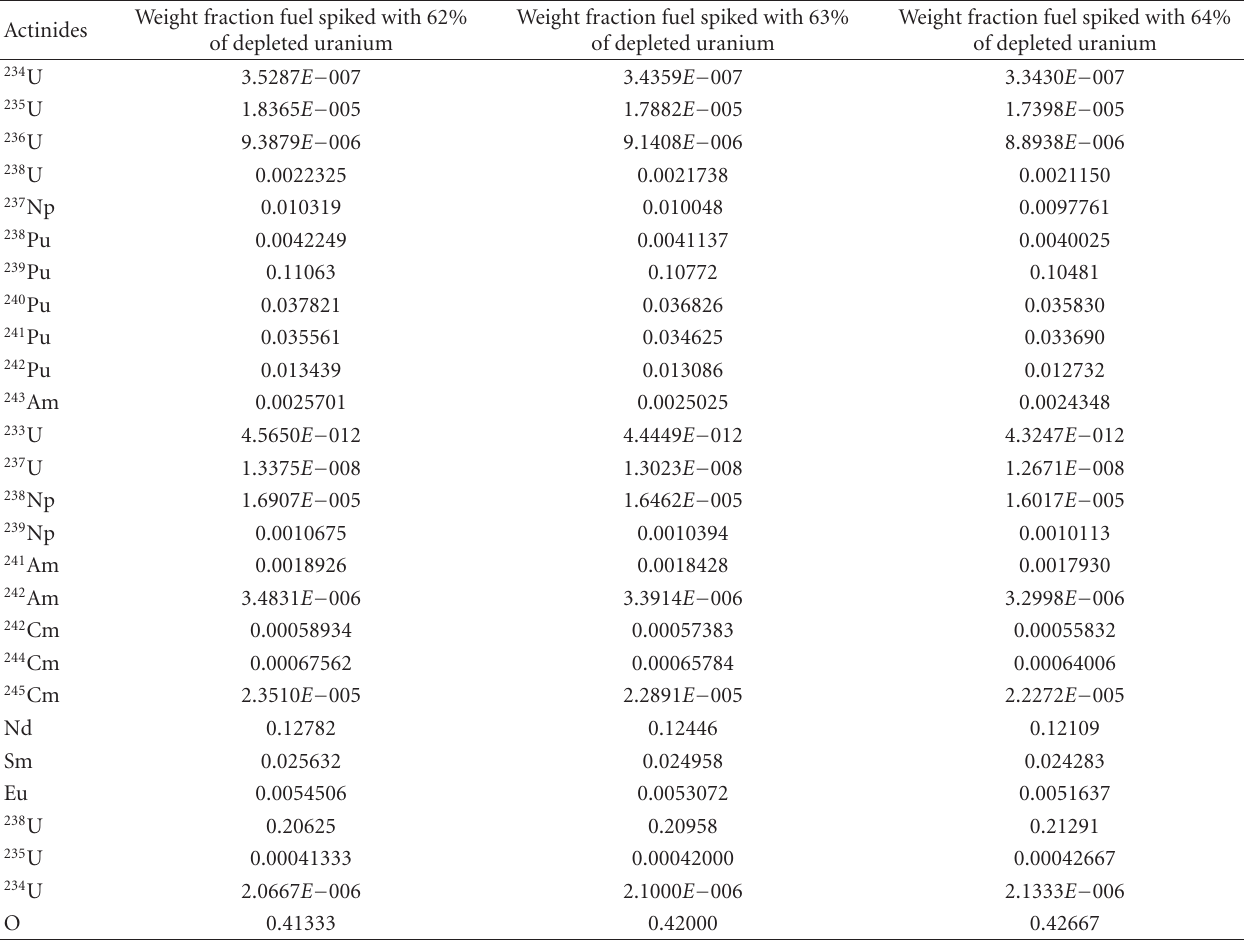
Table 4: Fuel composition (normalized) for the reprocessed fuels spiked with depleted uranium.